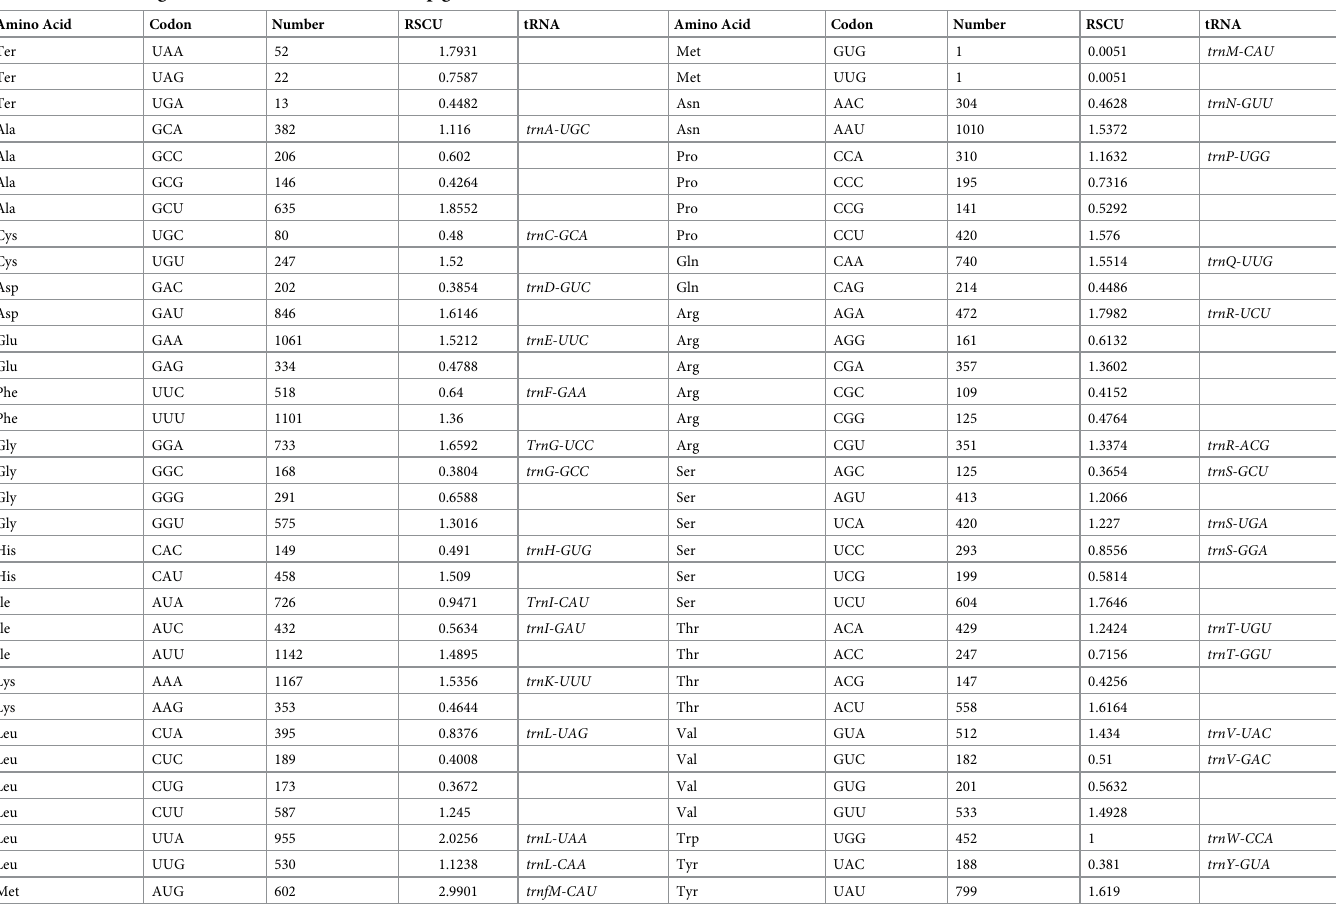
Table 6. Codon usage in the B . oleracea var. italica cp genome. AminoAcid